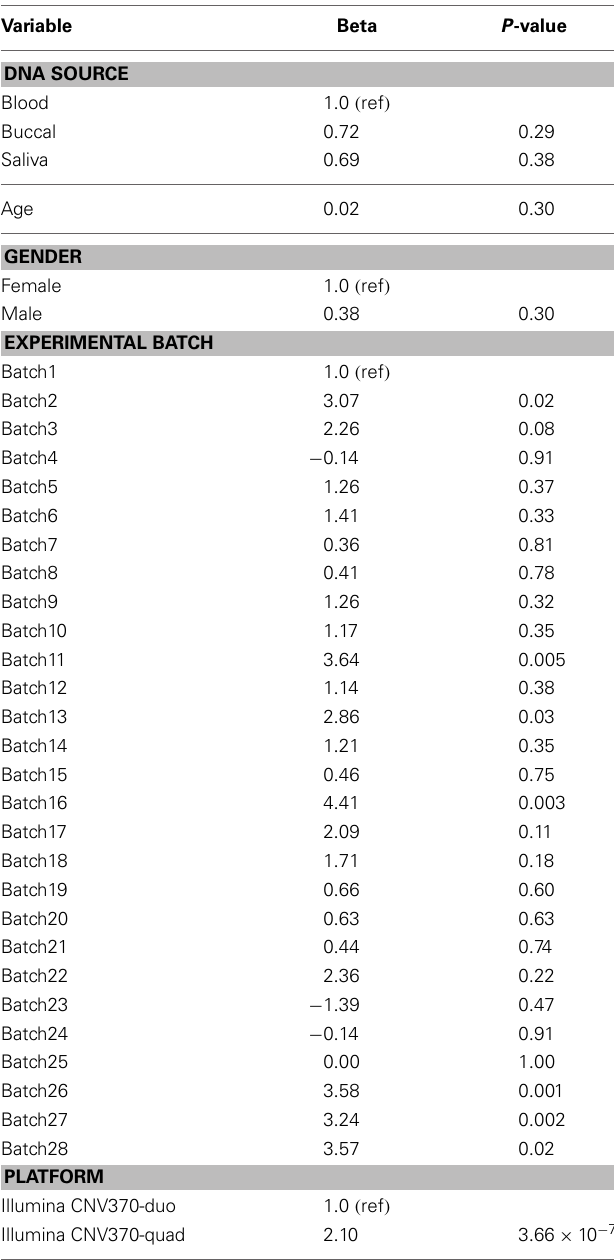
Table 1 | Association of demographic and experimental factors with CNV